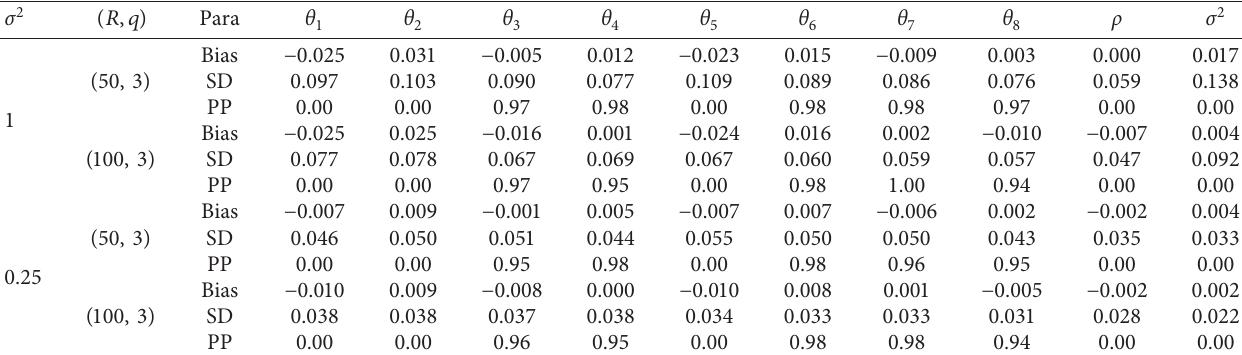
Table 3: Bayesian estimates of unknown parameters under different cases when ρ � − 0 . 5 .